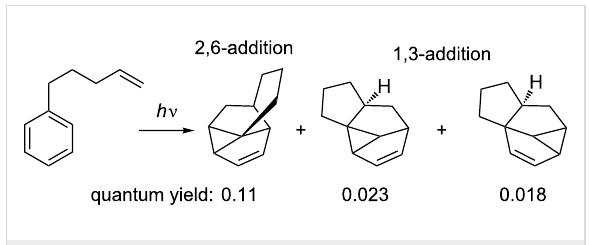
Scheme 11: 2,6- and 1,3-addition in intramolecular